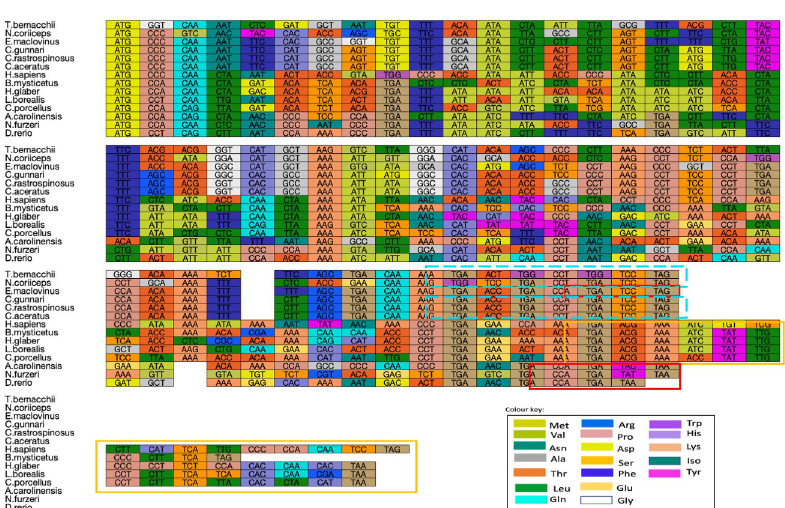
Fig 1. Multiple sequence alignment for nucleotide sequences of ATP synthase subunit 8. Multiple codon alignment of nucleotide sequences of ATP synthase subunit 8 was created using the Clustal omega alignment of nucleotides we screened five Antarctic and one sub-Antarctic fish species and eight vertebrate outgroups same as ATP6 MSA (See Fig 1 for colour key). The highlighted boxes show the overlap of the ATP8 and ATP6 sequences for different species where different colour of the boxes correspond to the different lengths of